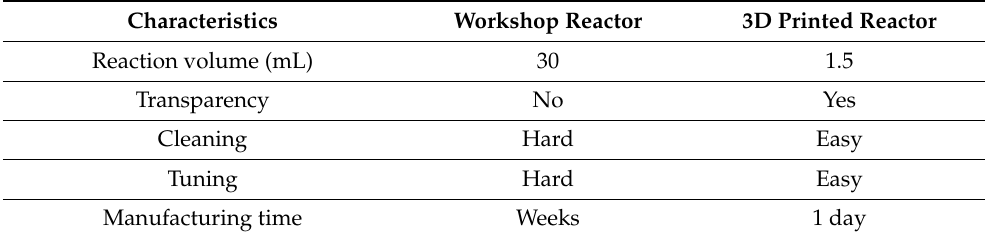
Figure 2. Top view of the rendered design of the final prototype of the reactor.